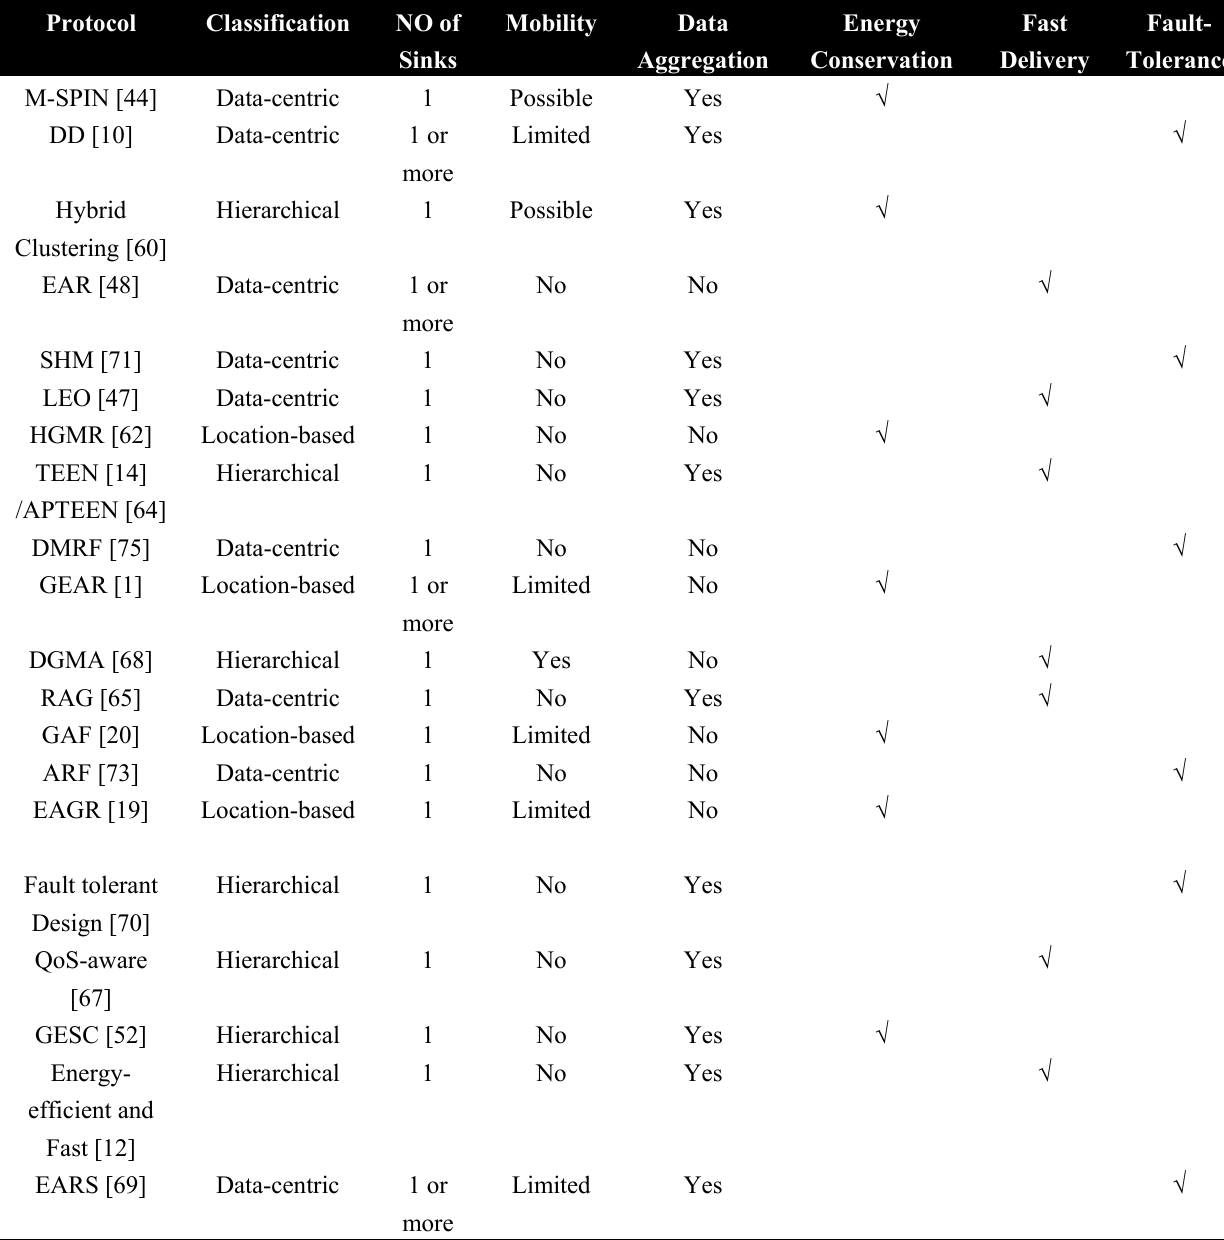
Table 1. Features and goals of data routing